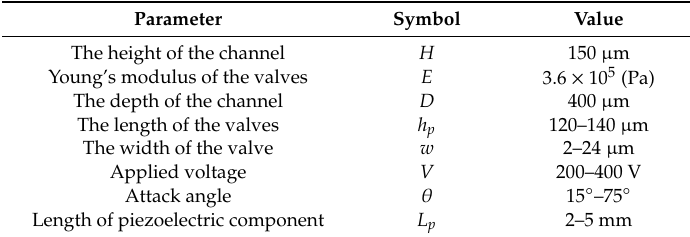
Table 1. The inputs of the model.